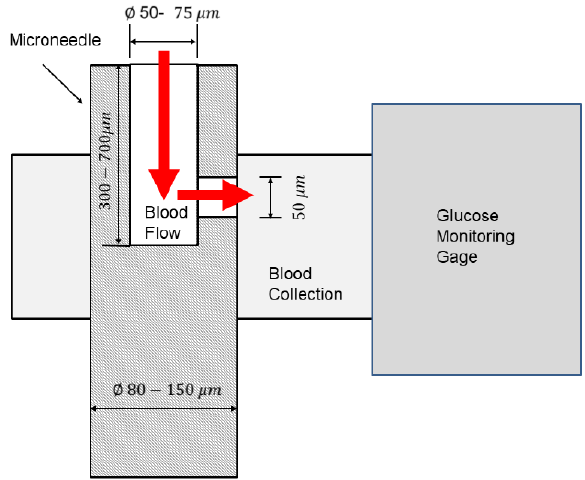
Figure 1: An envisioned microneedle, made of a thin nitinol wire, combined with a glucose monitoring